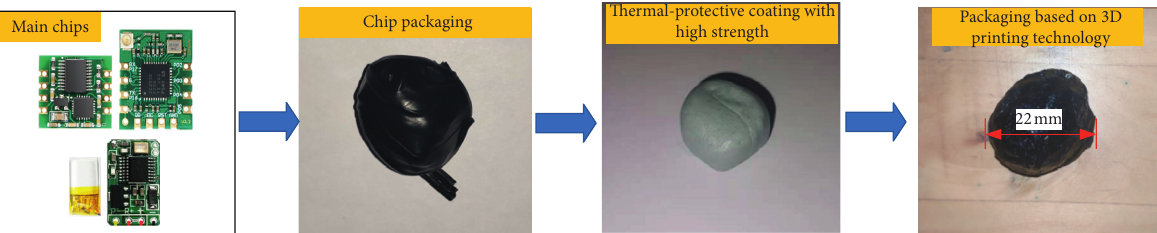
Figure 3: The preparation process of ISA.